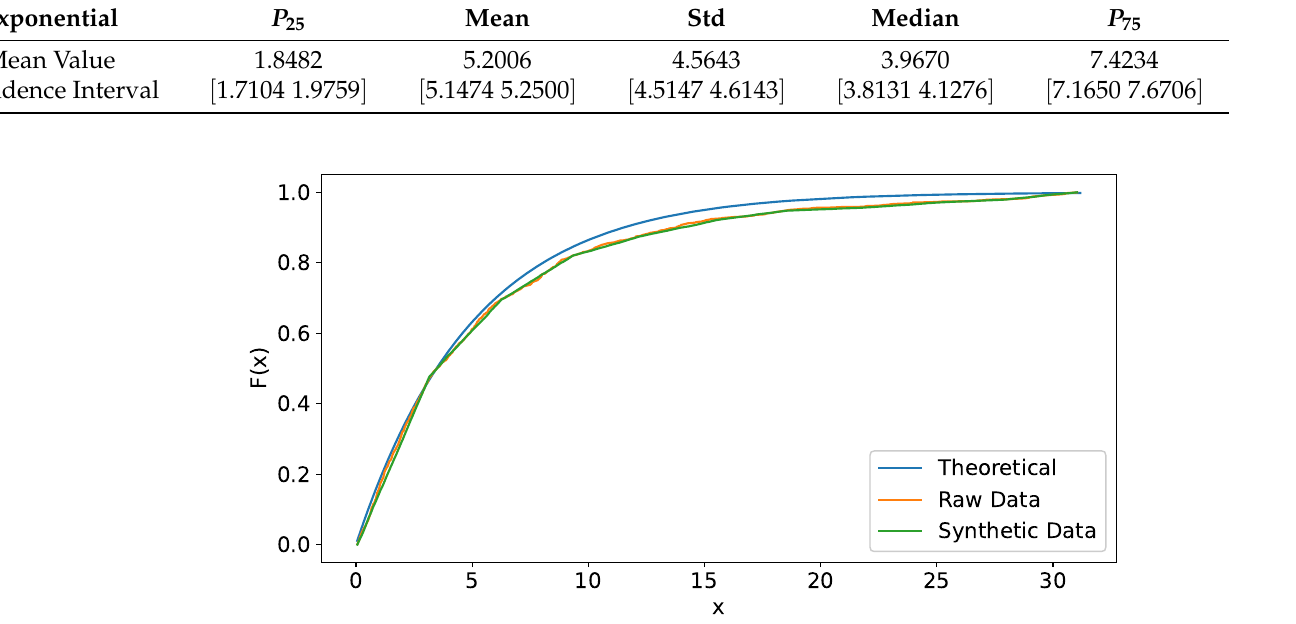
Figure 3. Theoretical distribution and empirical distribution of raw data and synthetic